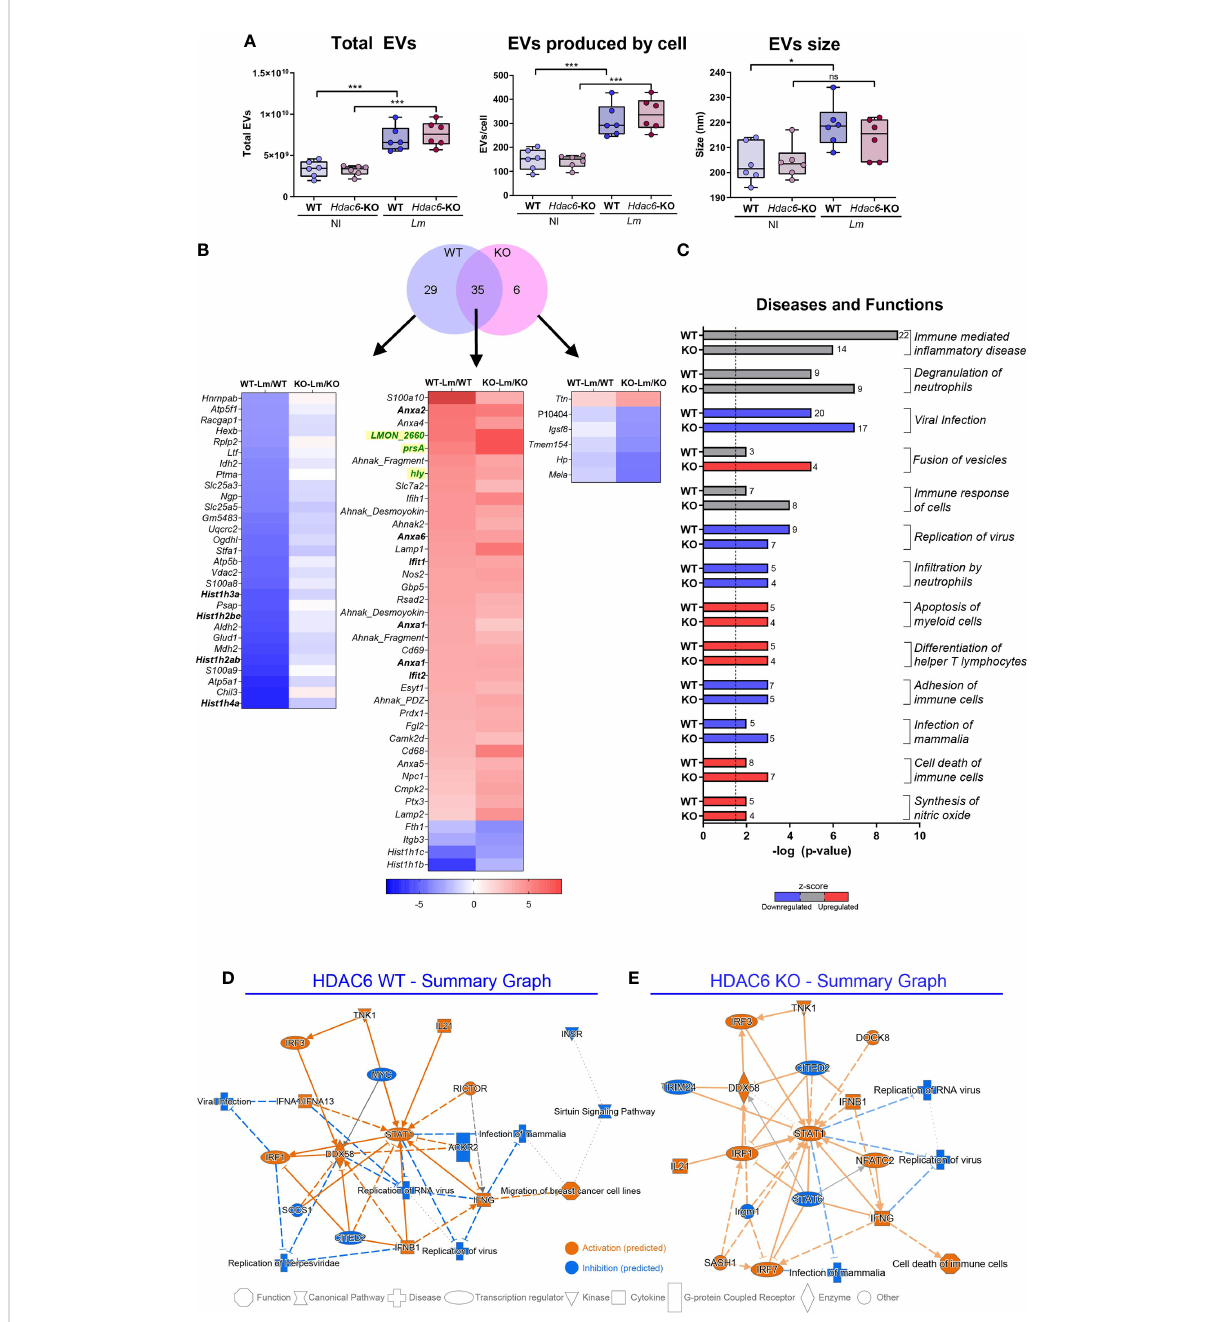
FIGURE 2 EVs secreted during infection with Lm present a different protein pro fi le. (A) NTA of EVs isolated by ultracentrifugation from Lm -infected or non-infected Hdac6 + /+ (WT) or Hdac6 -/- (KO) DCs. Plots show total EV numbers, number of EVs produced per cell and the mean size of the EV population in µm from left to right, respectively ( n = 6, t-test; * P < 0.05, *** P < 0.001 and ns, not signi fi cant). Rows are labeled according to gene name. (B) Venn diagram shows the number of signi fi cant protein abundance changes detected in EVs of DCs after Lm infection (FDRq < 0.05 in at least one condition). The heatmap represents proteins altered in EVs for each group and condition (the gene name is indicated except for P10404, which lacks gene ascription). Lm proteins are colored in green. (C) Horizontal bar chart of diseases and functions predicted to be altered by IPA. A – log ( P- value) = 1.3 ( P- value = 0.05) threshold was considered for statistical signi fi cance (dotted line). Predicted upregulation (positive z-score, in red), or downregulation (negative z-score, in blue) is shown (z-scores corresponding to uncertain predictions are indicated in grey). Bar numbers represent the number of protein components detected in the corresponding category. (D, E) IPA graphical summary of WT (D) and KO BMDCs (E) upon 12 hpi presenting the key results of the analysis as a network. Solid lines depict direct interaction, slashed lines show indirect interaction and dotted lines represent inferred correlation from machine-based learning. Colors show IPA predictions (orange, predicted activation; blue, predicted inhibition; and grey, no prediction). Color intensity depicts grade of con fi